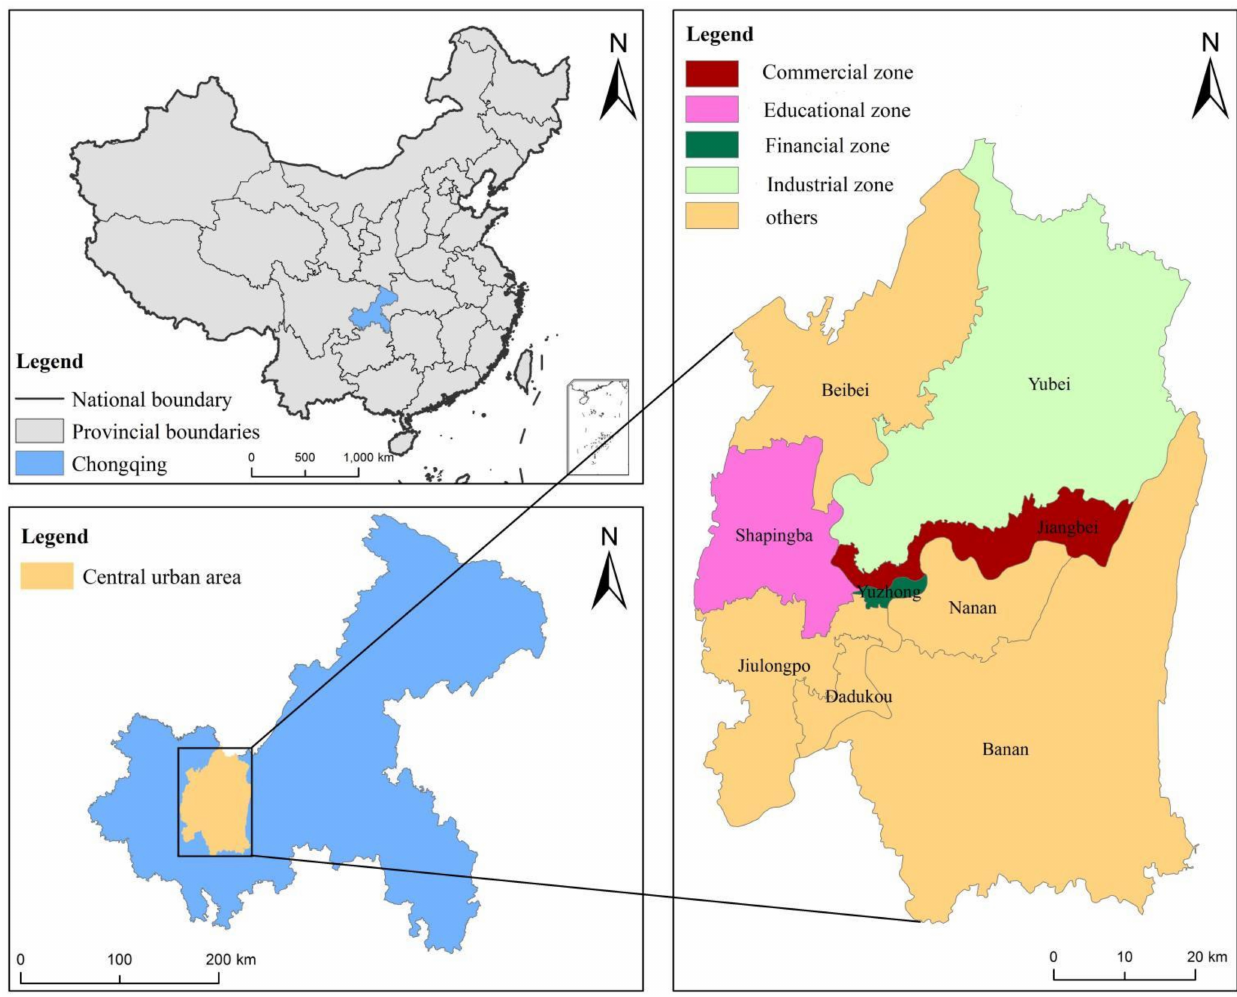
Figure 2. The map of the study area and four urban functional zones in